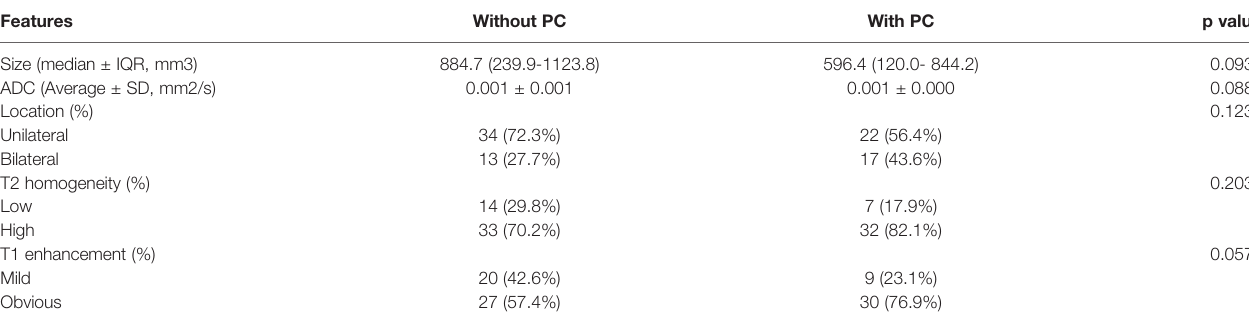
SD, standard deviation; IOR, interquartile range; ADC, apparent diffusion coef fi cient; PC, peritoneal metastasis.